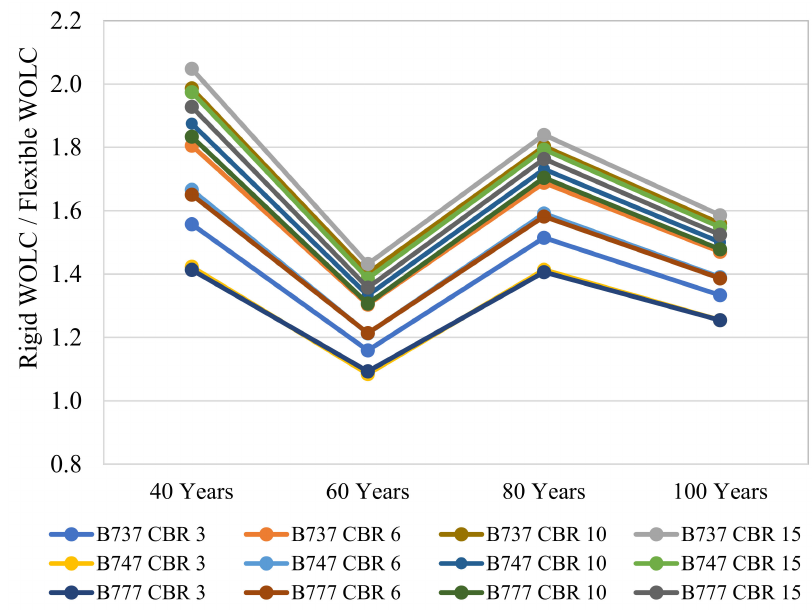
Figure 10. Effect of analysis period on rigid/flexible WOLC cost